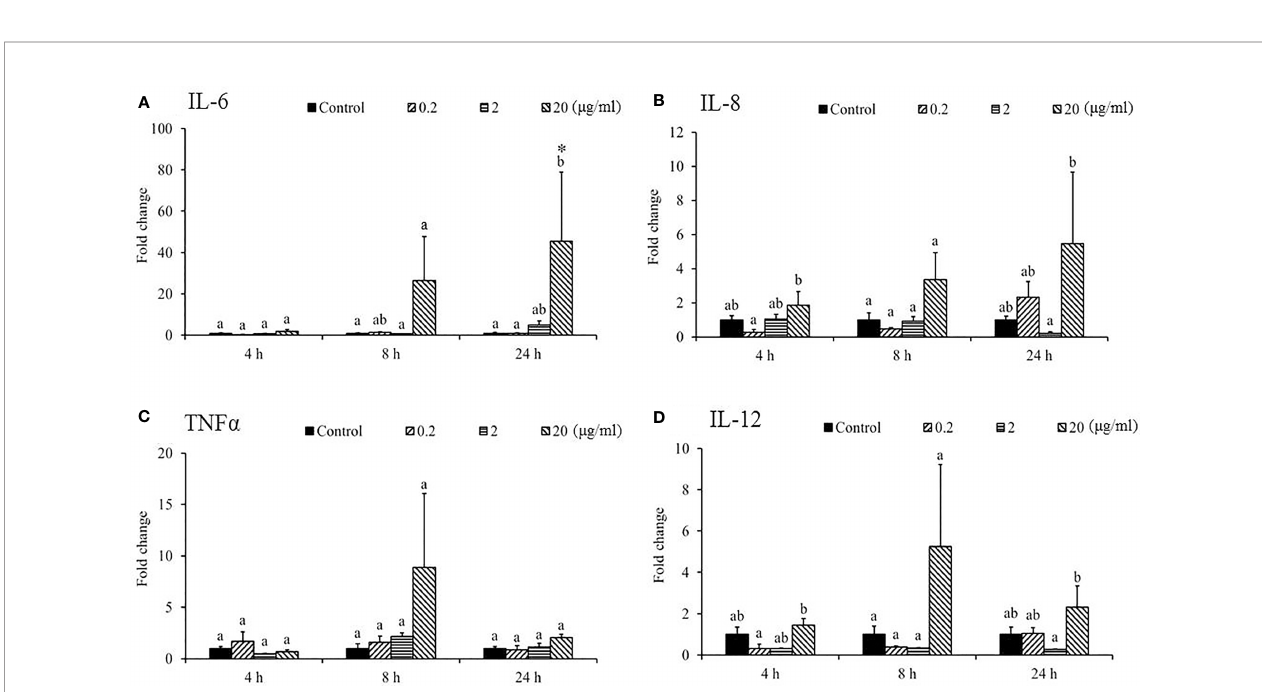
FIGURE 4 | Expression of cytokine genes in the spleen tissue from Sarcodia suiae water extract (SSWE) treated cobia. Spleen samples were collected from fi sh injected with PBS (Control) or SSWE and the expression of (A) IL-6 , (B) IL-8 , (C) TNF a , and (D) IL-12 was analyzed. The values are shown as mean + SEM (N = 3). Signi fi cant differences between samples and their time matched control group are shown with asterisks (* p < 0.05 ) and differences between groups are indicated by different letters.